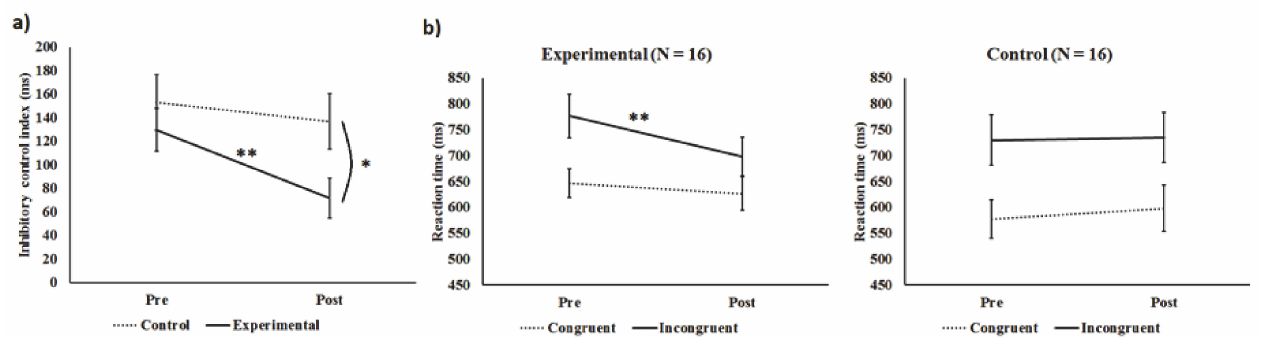
Figure 1. ( a ) Inhibitory control index. ( b ) Mean reaction time in the experimental ( n = 16) and control groups ( n = 16). “Pre” and “Post” refer to the test performance of participants before and after real training/no training period, respectively. Error bars represent 1 standard error ± the mean. Asterisks indicate the level of significance of t-tests (two-tailed). * p < 0.05, ** p <